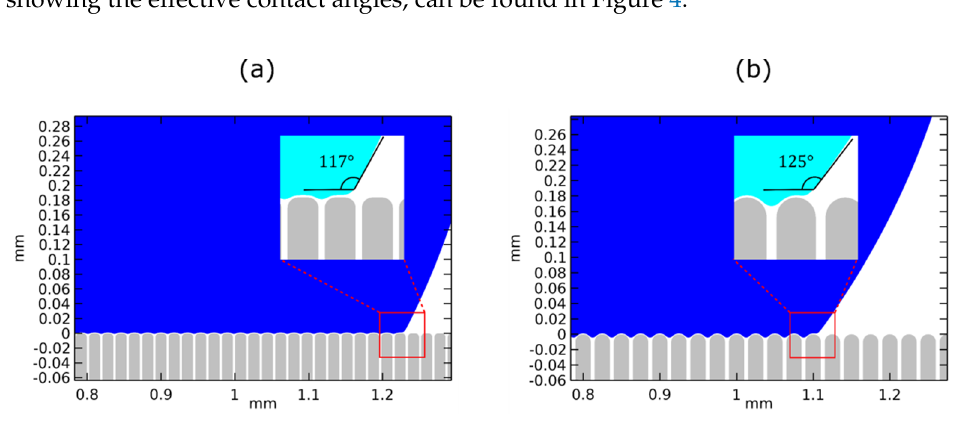
Figure 4. Magnification of the droplet equilibrating over surface asperities with a Young’s contact angle (cid:2016) (cid:3026) = 107° (equivalent to electrowetting actuated state) for ( a ) ℎ = 85 μm , (cid:1875) = 15 μm , (cid:1856) = angle θ Y = 107 ◦ (equivalent to electrowetting actuated state) for ( a ) h = 85 µ m, w = 15 µ m, d = 3 µ m 3 μm and (cid:1870) = 5 μm with an effective contact angle of 117° and ( b ) (cid:1856) = 75 μm , (cid:1875) = 20 μm , (cid:1856) = and r = 5 µ m with an effective contact angle of 117 ◦ and ( b ) d = 75 µ m, w = 20 µ m, d = 5 µ m and 5 μm and (cid:1870) = 10 μm with an effective contact angle of 125° . r = 10 µ m with an effective contact angle of 125 ◦